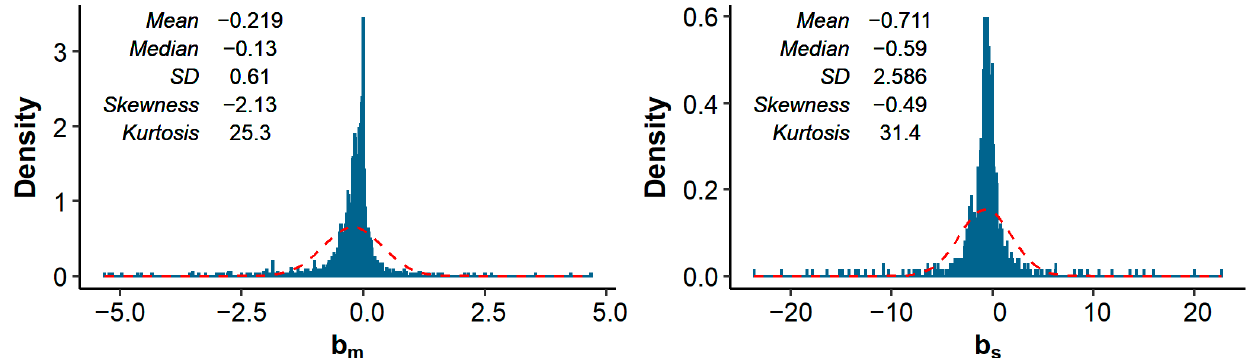
Figure 1. Histograms of estimates of b m ( n = 1818) and b s ( n = 1259) across all studies and traits, after removal of extreme outliers. Descriptive statistics and a normal distribution (dashed red lines; based on mean and standard deviation (SD)) are also shown.